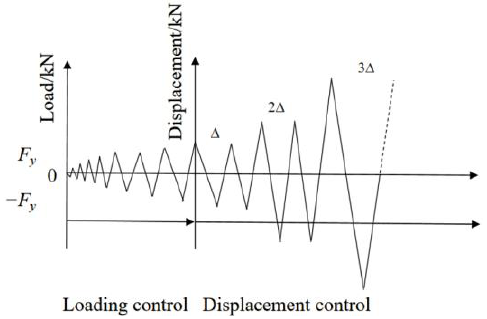
Figure 5. Horizontal loading system.